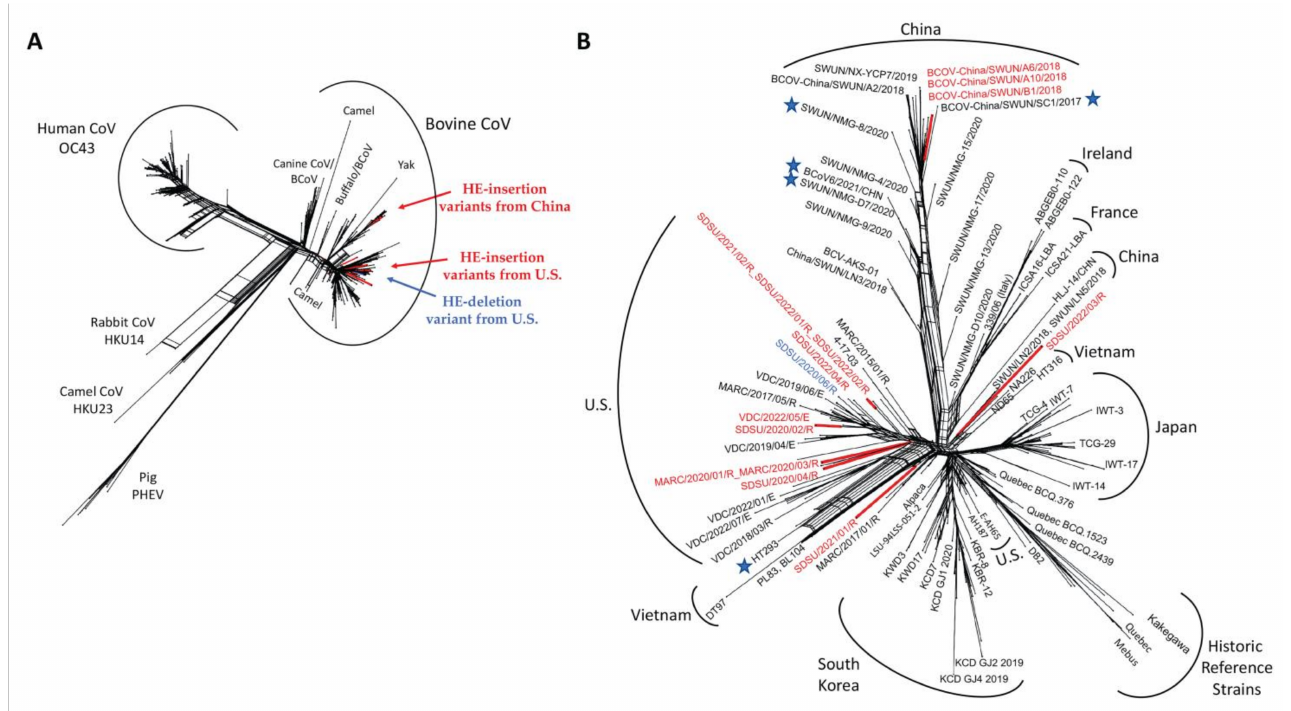
Figure 4. SplitsTree NeighborNet phylogenetic networks of HE gene sequences used in recombination detection. ( A ) NeighborNet of 491 unique Betacoronavirus HE gene sequences. GenBank accession OK391229 was removed from phylogenetic analysis due to poor sequence quality. ( B ) NeighborNet of 256 unique BCoV HE gene sequences. Stars represent the HE gene sequences flagged as potential recombinant sequences by RDP5. HE-insertion variants are colored red and the single HE-deletion variant is